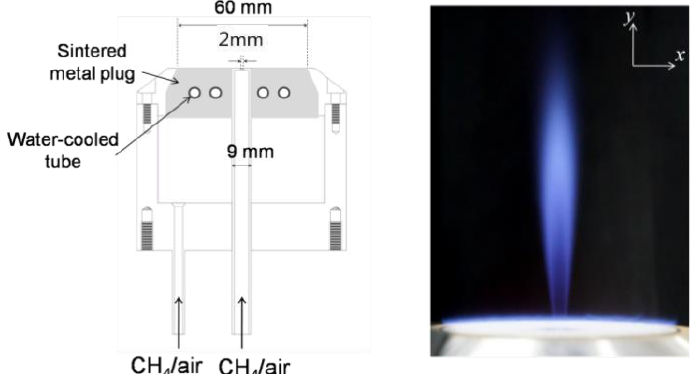
Figure 1. Overall structure of the jet flame and self-luminescence photograph of the flame.